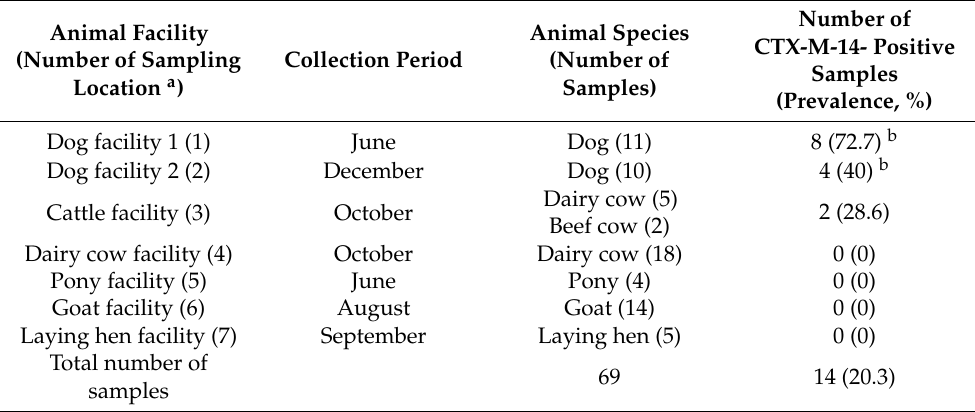
Table 1. Prevalence of CTX-M-14-producing Escherichia coli in domestic animals in the Gifu University campus in 2016 and their antimicrobial resistance